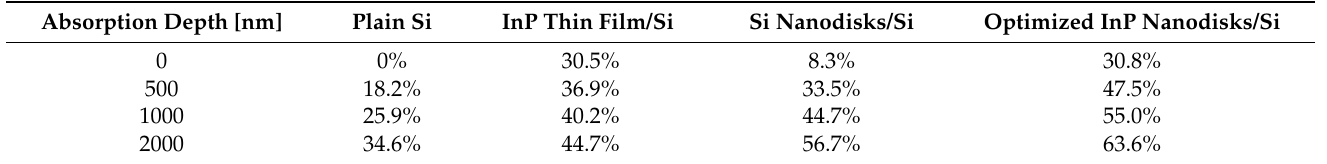
Table 1. Absorption in % at different depths in the Si substrate with different structures as top layer. Nanodisk array parameters for all different setups are: radius 80nm, pitch 250nm (hexagonal array) and height